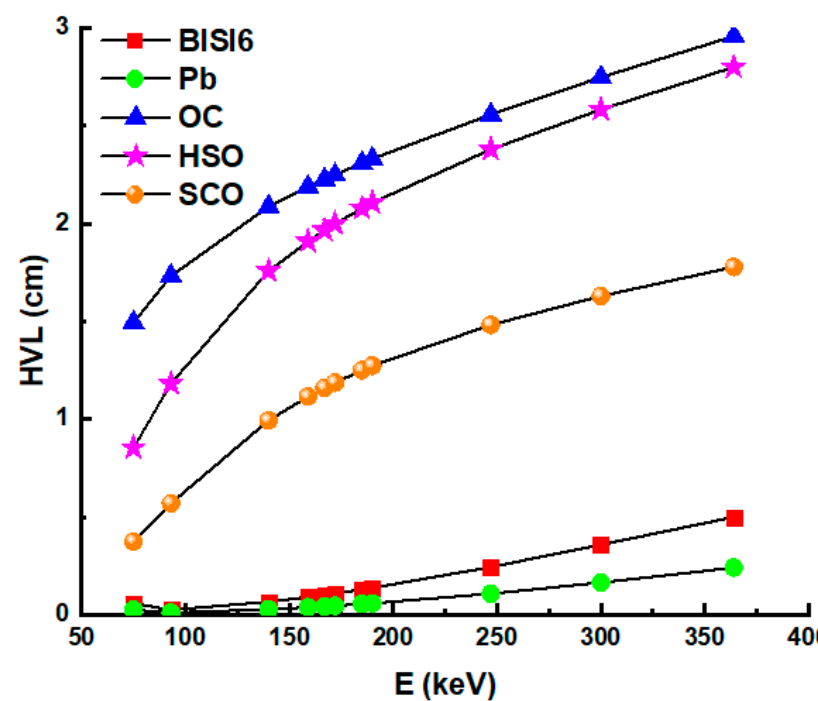
Figure 5. Half value layer (HVL) values of BISI6 glass samples Pb, ordinary concrete (OC), hematite- serpentine concrete (HSC), steel-scrap concrete (SCC) as a function of photon energy.